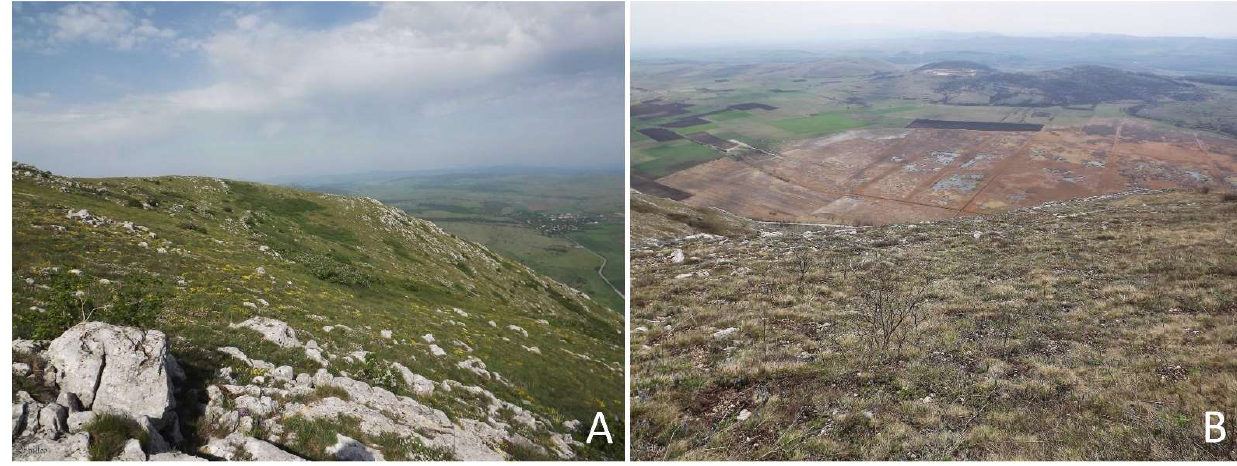
Figure 3. Habitat in the Chepan Planina Mt., where Carabus bessarabicus was found in pitfall traps. A : general view of the location; B : view from the sampling site towards Dragomansko Blato Marsh and a quickly developing quarry (on the hill at the back).